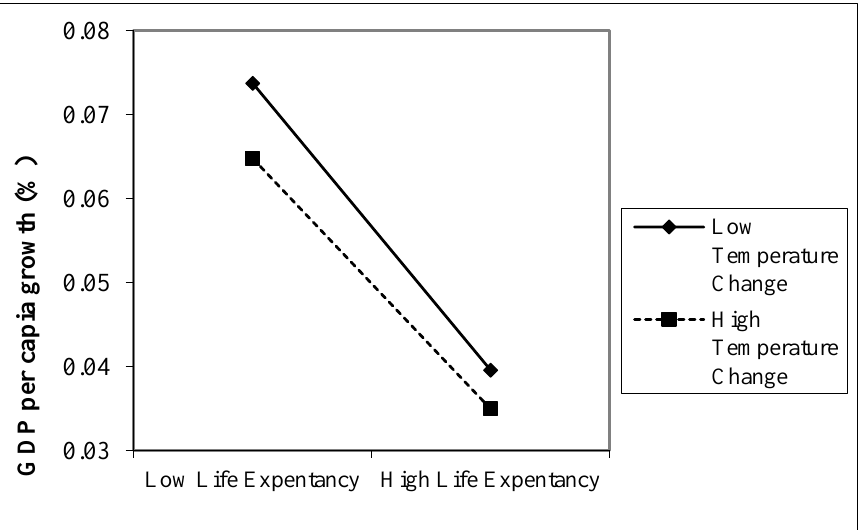
Figure 2. The two-way interaction effects for MDER and moderator (temperature change).